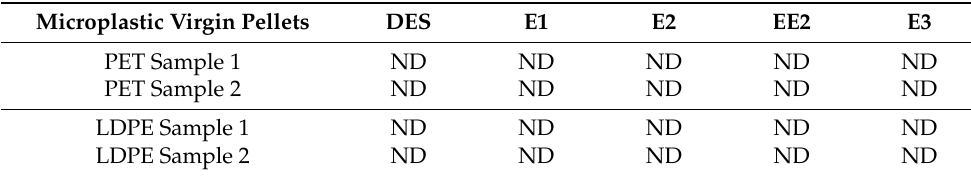
Table 2. Estrogens in LDPE and PET virgin